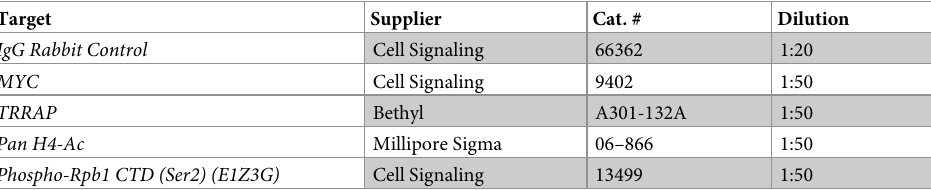
Table 2. Antibodies used in CUT&RUN experiment.